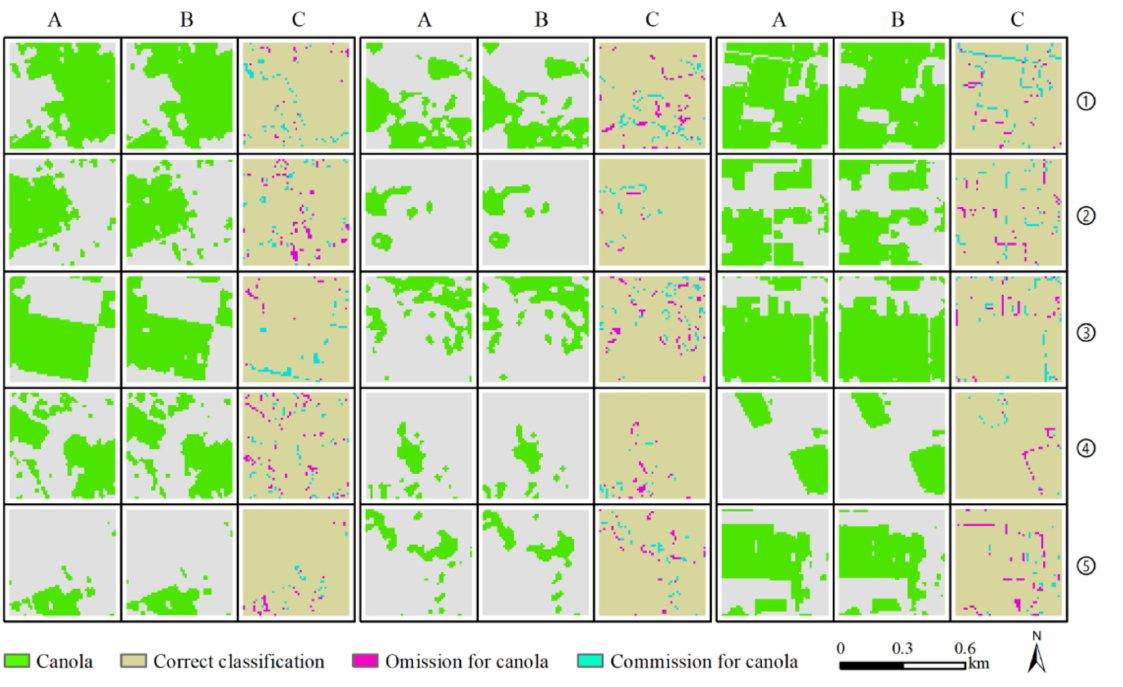
Figure 8. Results of accuracy validation based on 15 validation quadrats with dimensions of 0.5 km × 0.5 km, selected randomly from 45 validation quadrats. Columns A, B, and C are ground- truth data, classification results, and accuracy results,